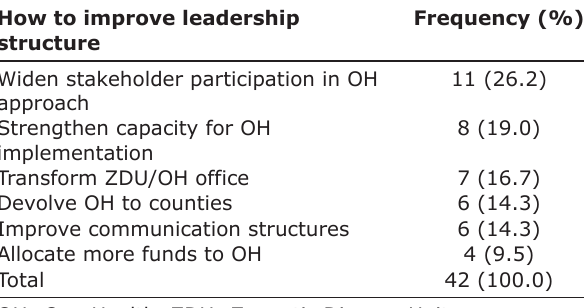
Table-10: Suggestions for improvement of current leadership/organization structure for the OH